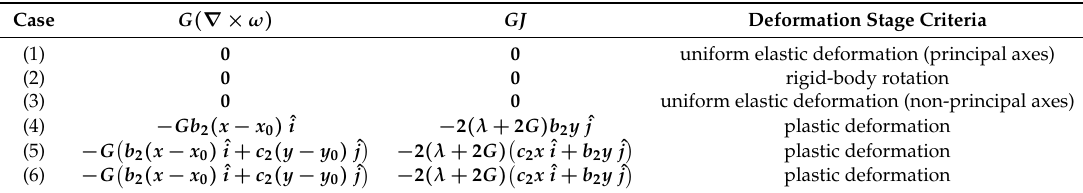
Table 3. u - and v -fringe shapes and corresponding deformation